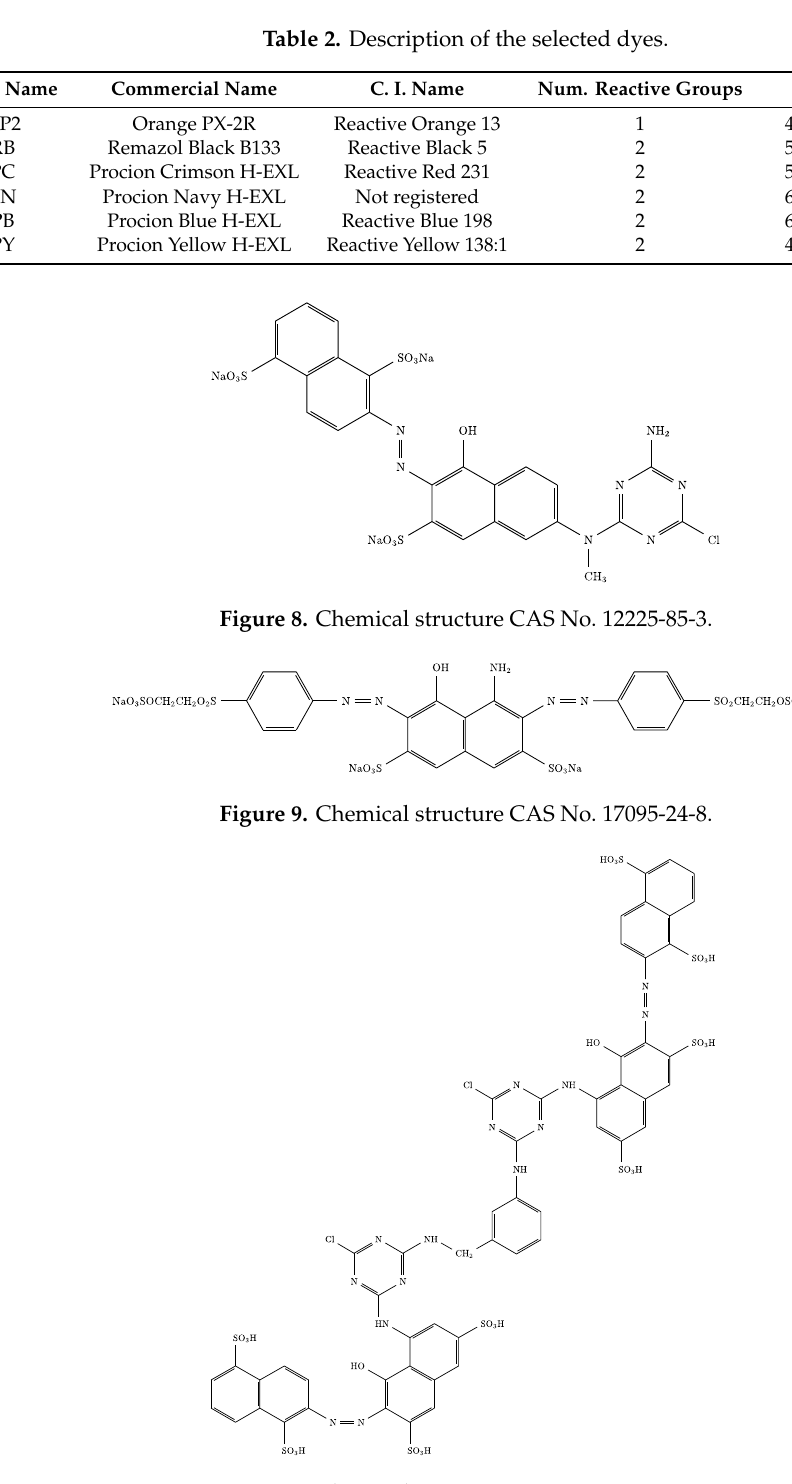
Figure 11. Chemical structure CAS No. 186554-27-8.